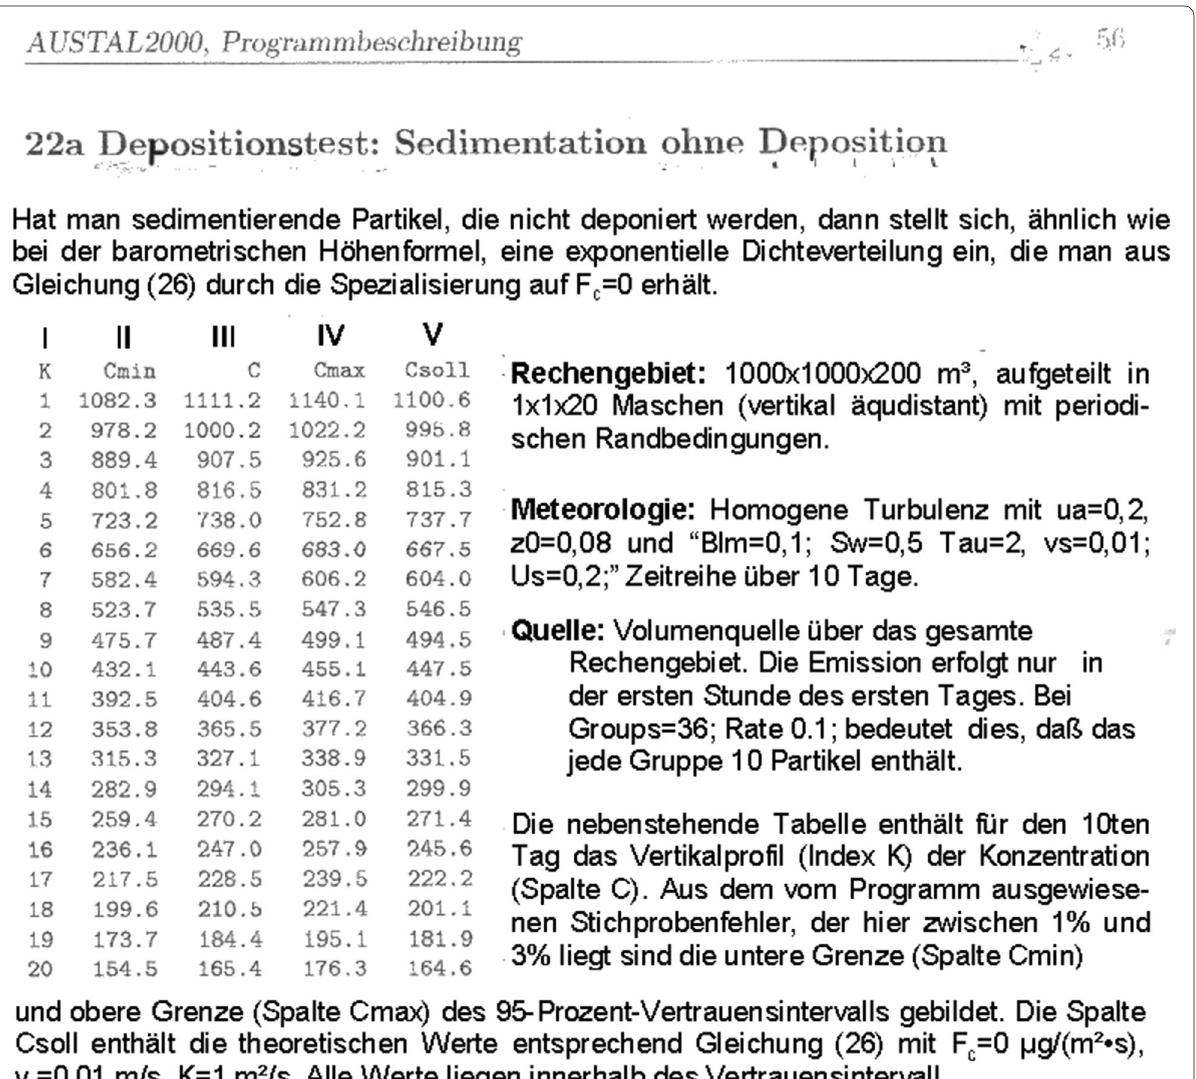
Fig. 2 Task of the AUSTAL authors “ Sedimentation without